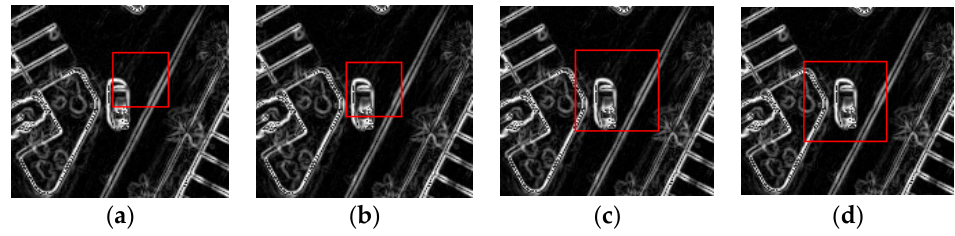
Figure 4. An example of a sliding window move. ( a ) An initial window; ( b ) moved to its geometric center; ( c ) enlarged; ( d ) moved to its new geometric center. Remote Sens. 2018 , 10 , 124